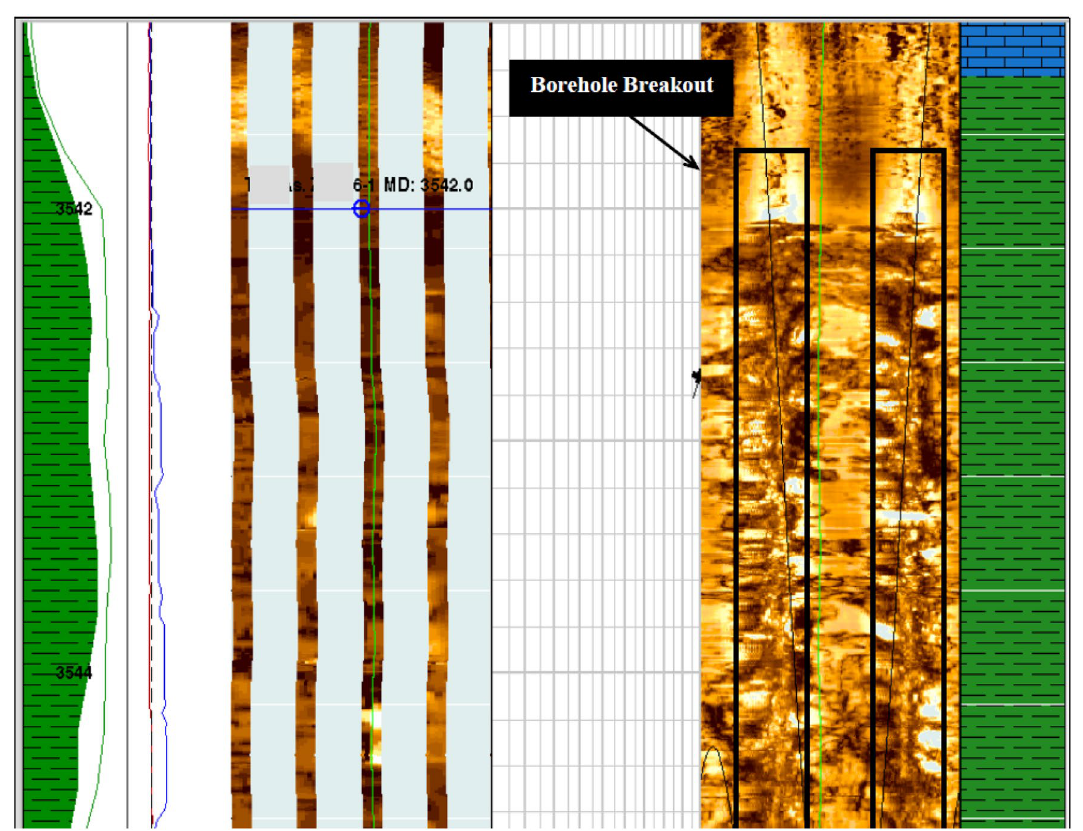
Fig. 8 An example breakout indicating the direction of minimum horizontal stress of